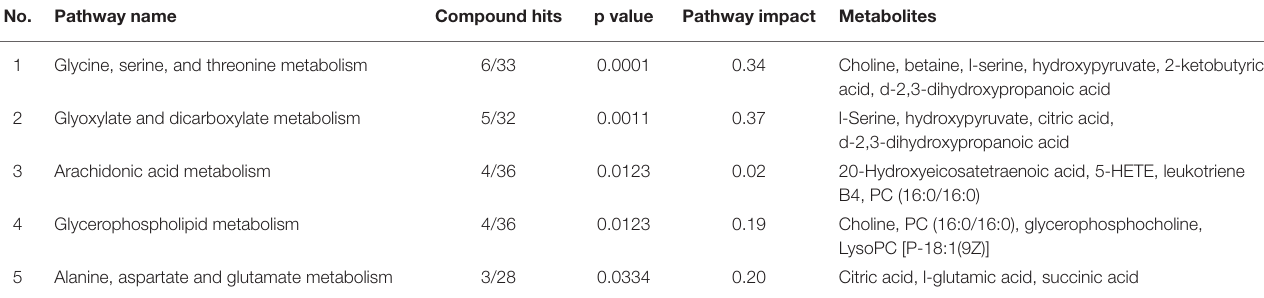
TABLE 3 | The top five metabolic pathways analysis via MetaboAnalyst based on all identified differential